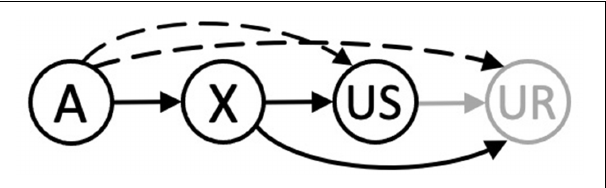
FIGURE 1 | An integrated schematic for higher-order conditioning: The associative chains (black continuous arrows) and retrieval mediated associations (black dashed arrows) resulting from separate A → X and X → US trials. The gray solid arrow is an (unconditioned) link between the US its UR. The A, X, and US nodes are held to be activated by their corresponding stimuli, with the UR generated by the presentation of the US.